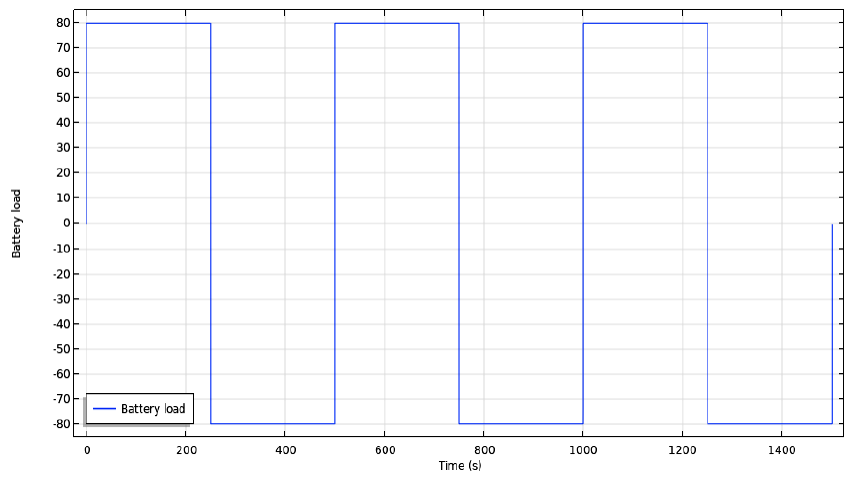
Figure 1. Battery load vs. time.